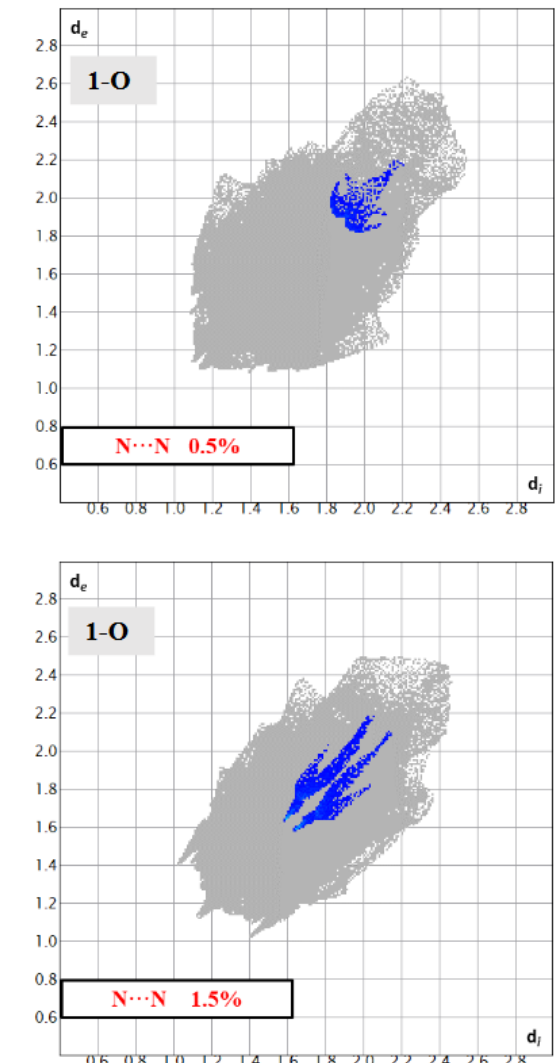
Figure 15. Fingerprints for 1-M and 1-O showing the C···C and N···N interactions.